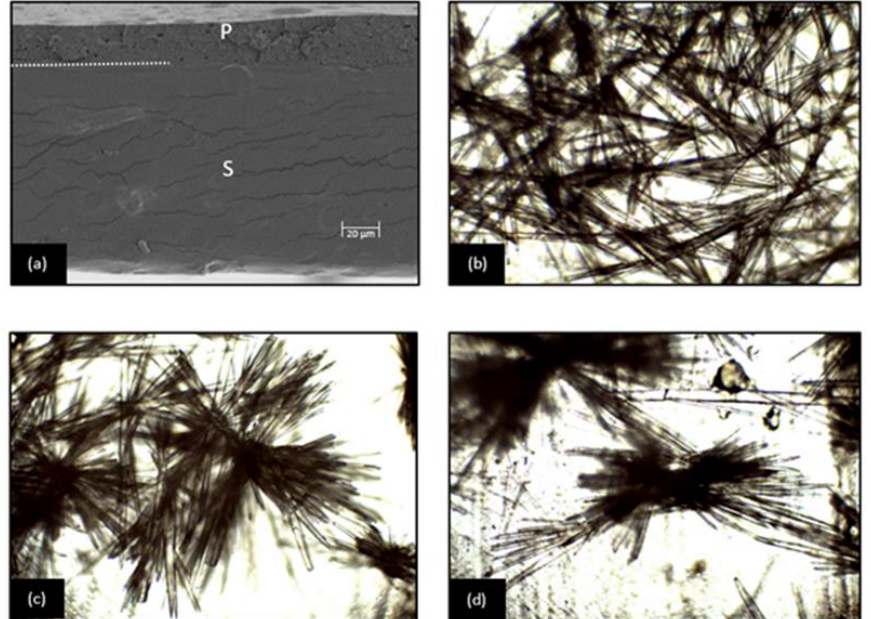
Figure 1. ( a ) FESEM micrograph of bilayer film (cross-section) of cassava starch-based films (S) and PLA:PHBV blend films (P). The polyester (P) and starch (S) sheets are marked, as well as the layer interface (dashed line). ( b – d ) Light microscopy images (40×) of FA crystalline formations onto the PLA surface of bilayers after spraying and drying the compound ethanolic solution. Table 1. Tensile properties (elastic modulus: EM, tensile strength: TS, and deformation at break: %E) and barrier properties (water vapor permeability (WVP), oxygen permeability (OP), and limonene permeability (LP)) of starch-polyester bilayer films (S-P) and FA coated starch-polyester bilayer films (S-P-AF) at time zero and after 1 and 2 storage months. Mean values and standard deviation. Bilayer Film